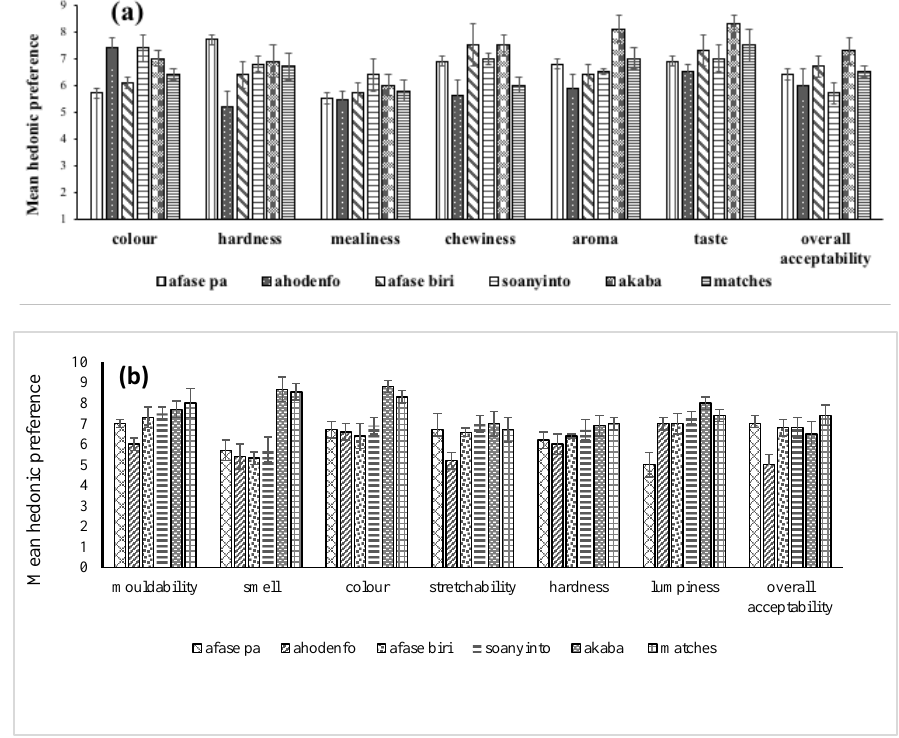
Figure 5. Preference level of quality descriptors of ( a ) boiled and ( b ) pounded Discorea alata varieties. 3.6. Multiple Comparison for D. rotundata Yam Varieties and Descriptors of Boiled and Pounded Yam. Multiple comparison for boiled yam from D. rotundata varieties varied significantly ( p < 0.05), as shown in Figure 6a. The most preferred variety was pona (local), which varied